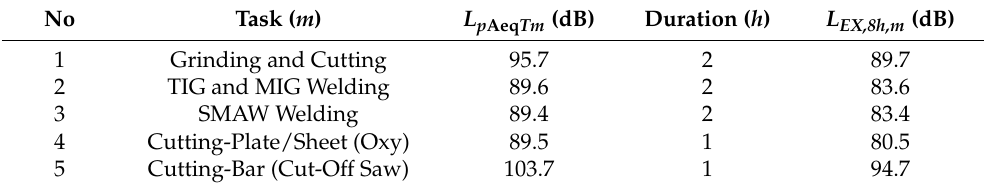
Table 2. A-weighted equivalent continuous sound pressure level and noise contribution from task m to the daily A-weighted noise exposure level results for work activities in the metal fabrication